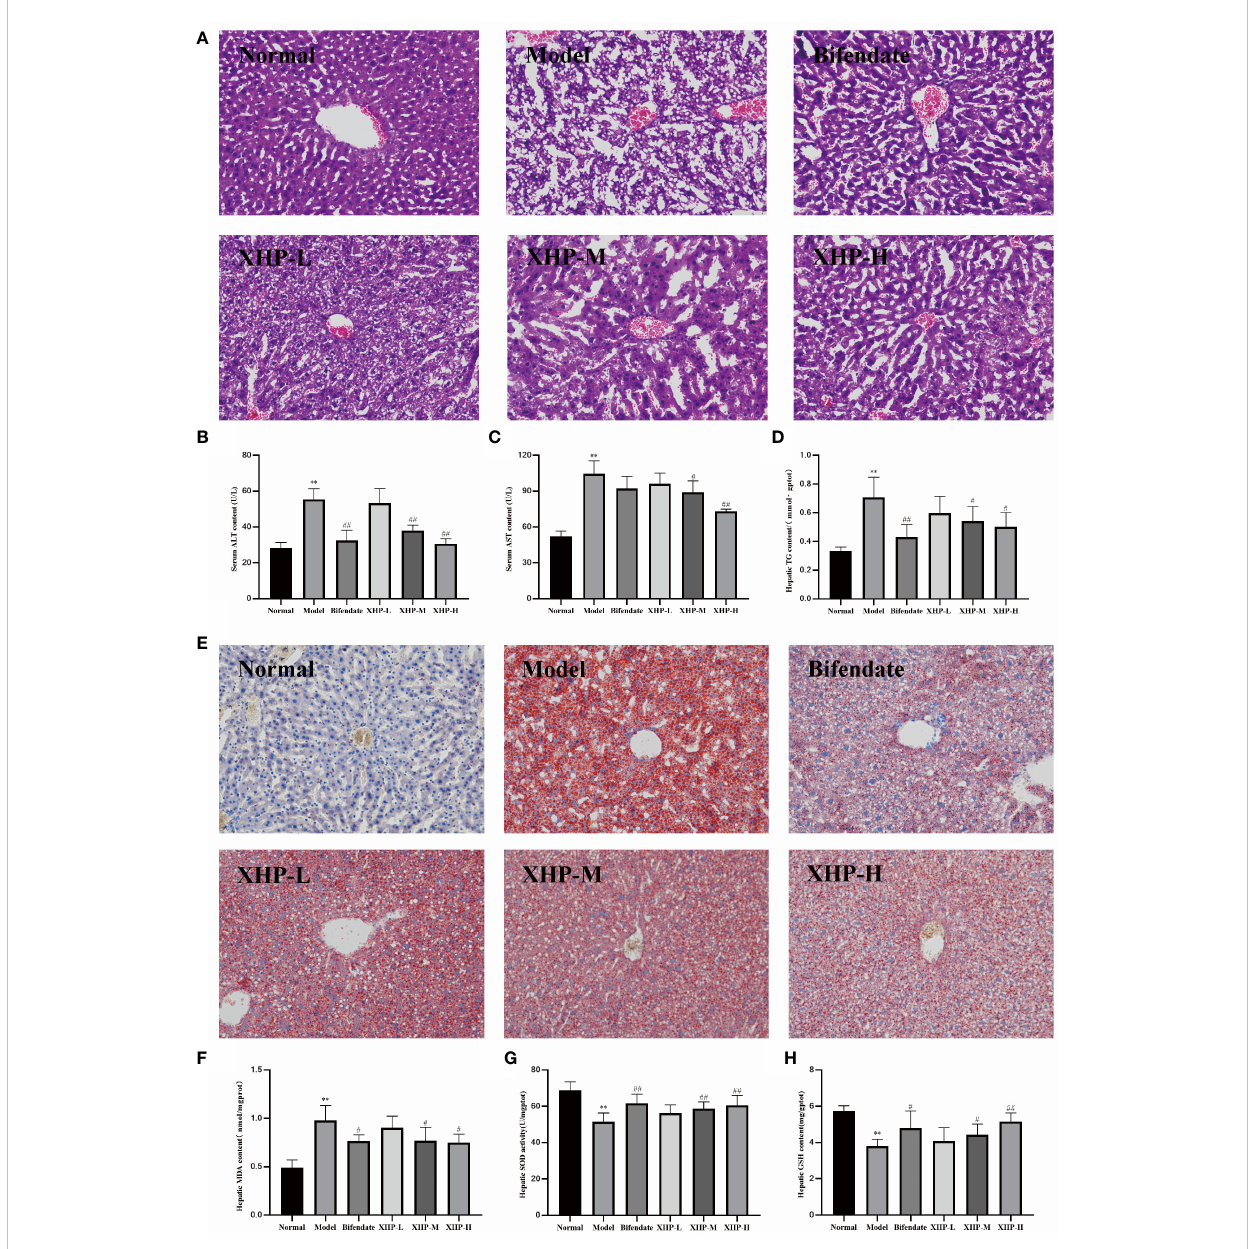
FIGURE 1 XHP alleviated lipid accumulation, oxidative stress, and degree of damage in the liver of alcohol induced mice. (A) Representative images of H&E (200×) staining of liver sections. (B, C) Serum ALT and AST contents. (D) Hepatic TG contents. (E) Representative images of Oil-red O (200×) staining of liver sections. (F) Hepatic MDA contents. (G) Hepatic SOD activities. (H) Hepatic GSH contents. Compared with the normal group, ** p < 0.01; compared with the model group, # p < 0.05, ## p <